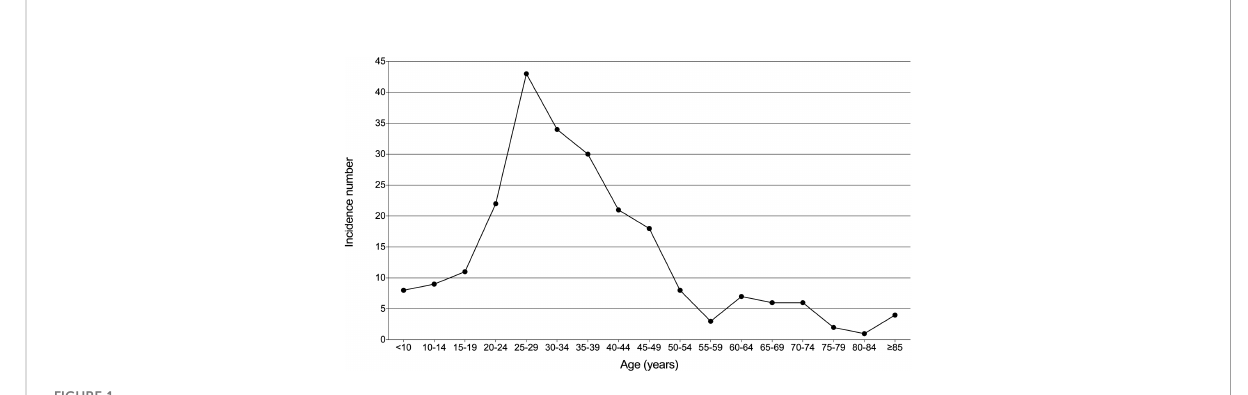
FIGURE 1 Age distribution of incidence in patients with thymic lymphoma from the SEER Research Data with 9 Registries (1975 –